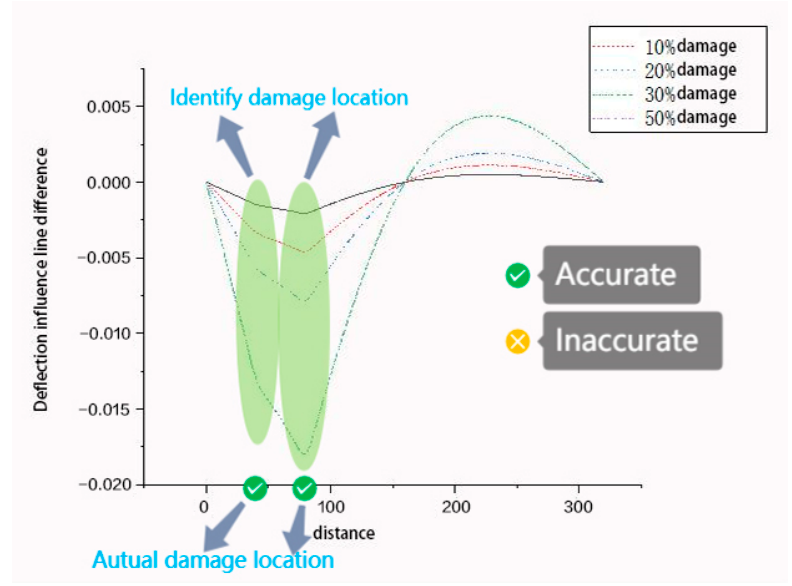
Figure 18. Deflection influence line difference of 3/4 determining points of the 1st span under work condition 2 (2-5).